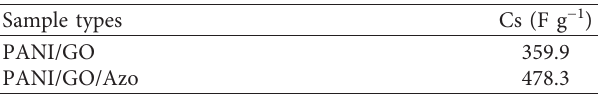
Figure 8: GCD curves of (a) PANI/GO and PANI/GO/Azo composites and (b) PANI/GO/Azo composites at different UV irradiation times. Table 1: The calculation results of Cs values of different composites.